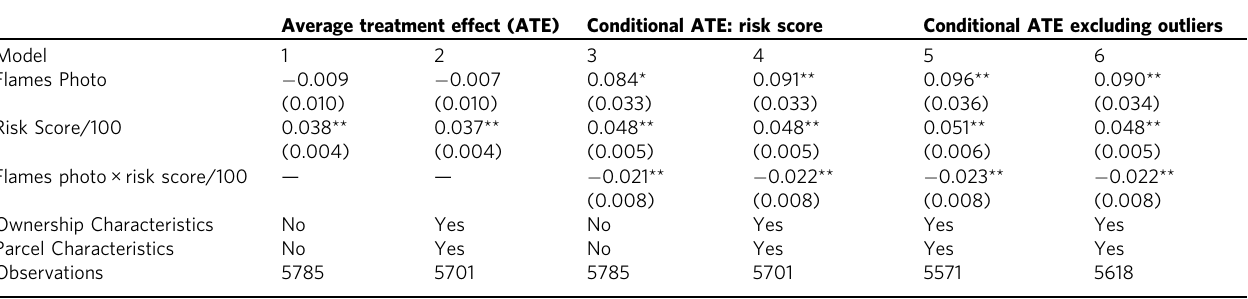
Table 2 The estimated average treatment effect of a fl ames photo on homeowners ’ information-seeking behavior in the fi eld